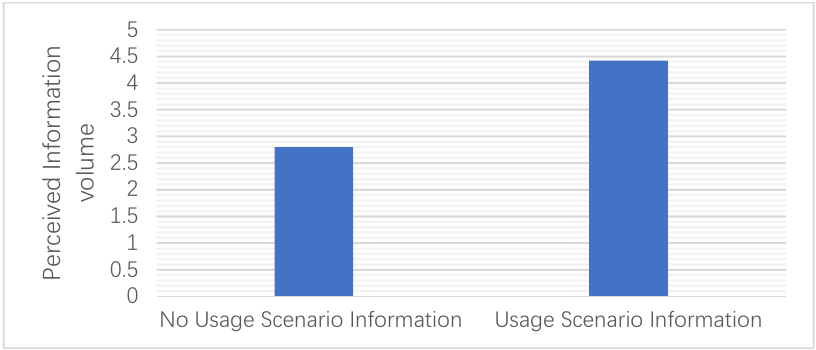
Figure 8. The influence of the usage scenario information on consumers’ perceived information volume.